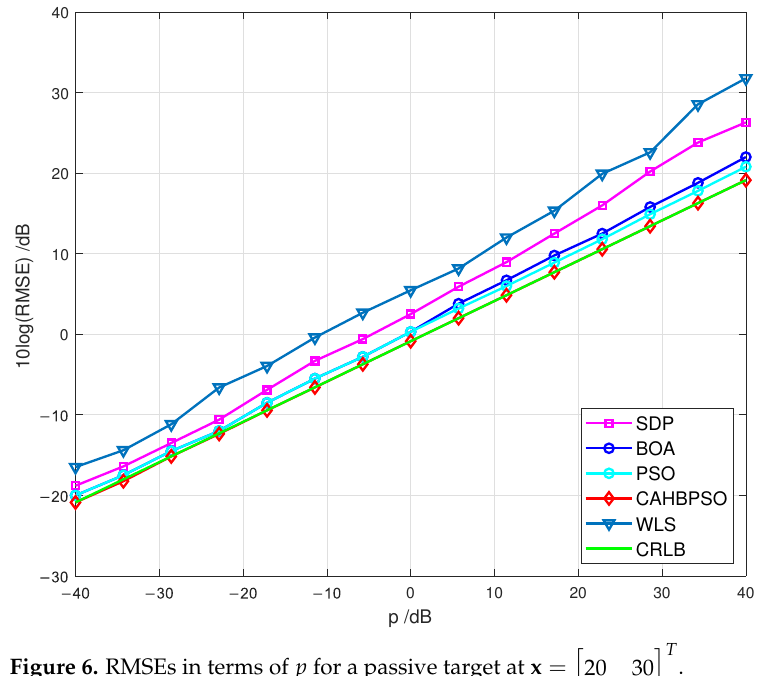
Figure 6. RMSEs in terms of p for a passive target at x =